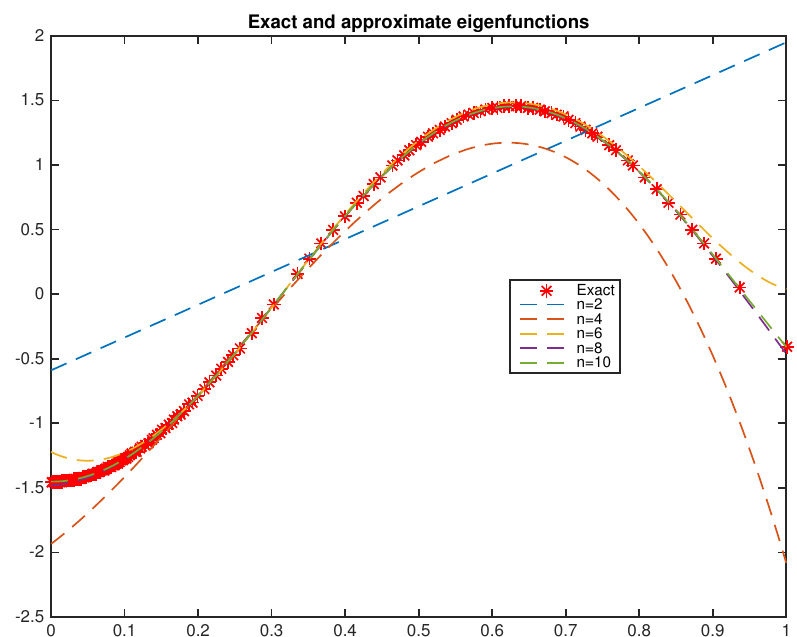
Figure 5. Exact and approximate eigenfunctions for the kernel K ( x , ξ ) = cos5 x cos5 ξ over [ 0,1 ] 2 at various truncation orders.